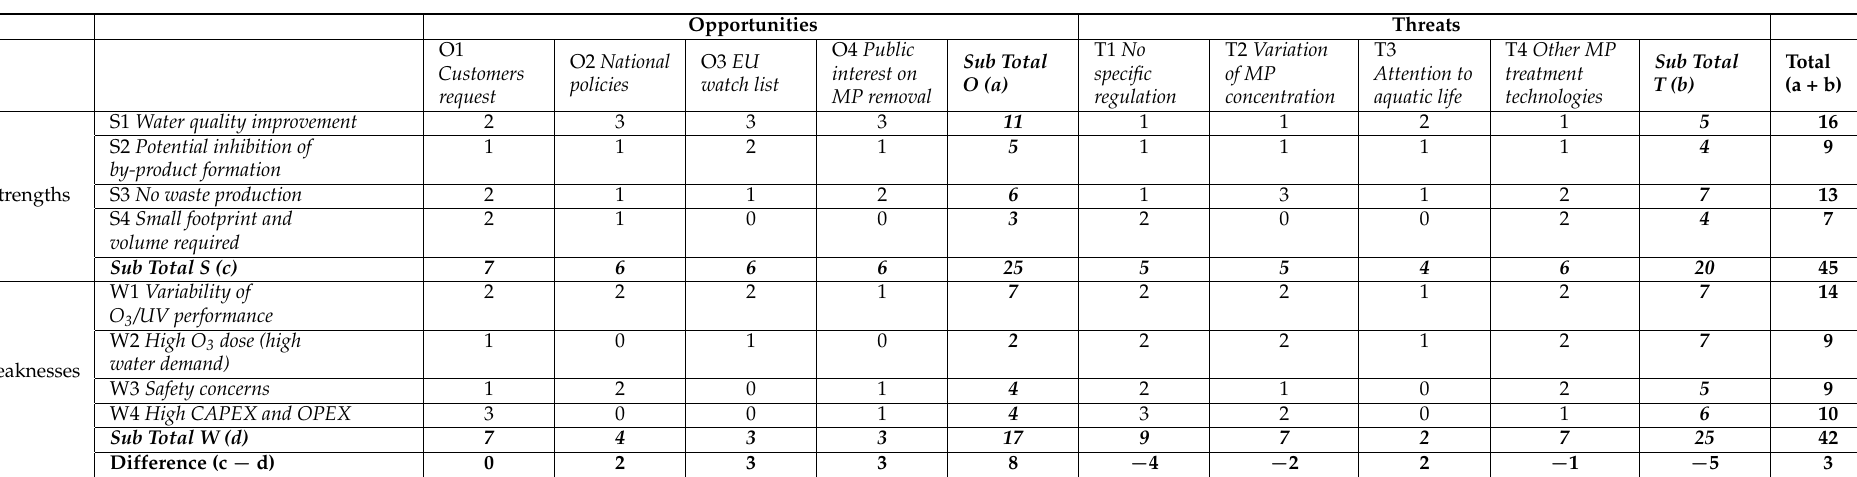
Table 6. SOR matrix for O3/UV